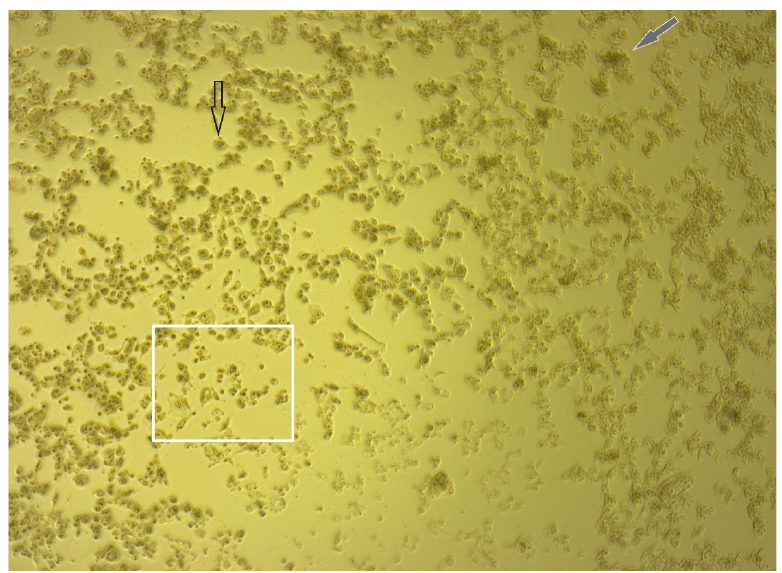
Figure 4. Photograph of an infected Vero E6 culture with typical signs of the virus-induced cytopathic effect, magnification 50×.